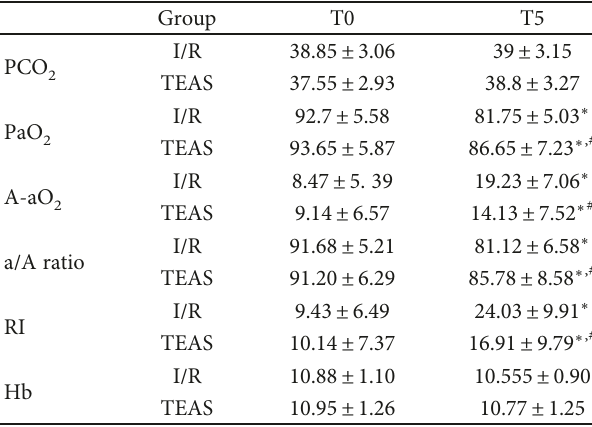
Table 3: Blood gas analysis ( n = 20 in each group). Data are expressed as mean ± standard deviation.